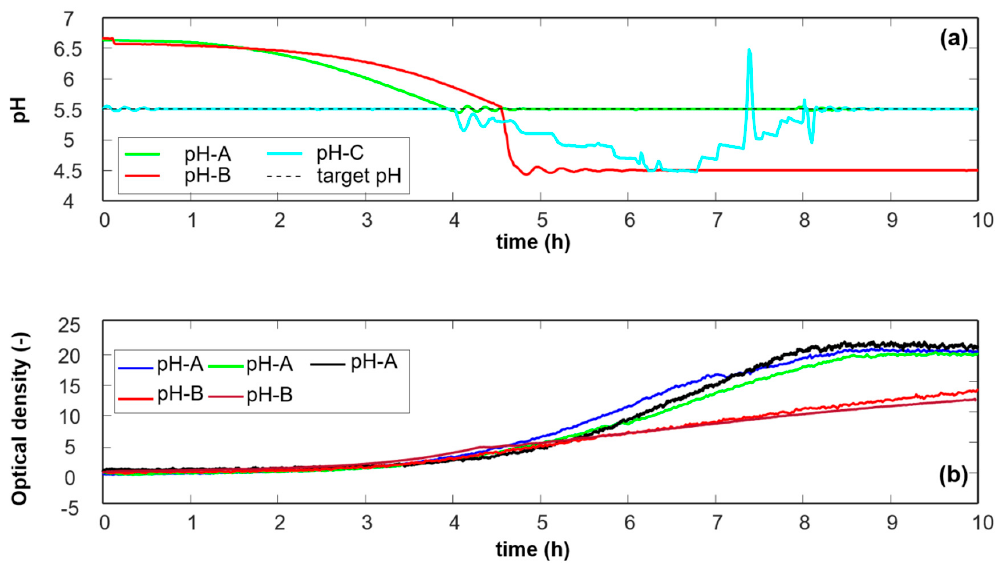
Figure 1. ( a ) Representative pH profiles and ( b ) OD profiles for three pH-A batches and two pH-B batches run in 2 L bioreactor.